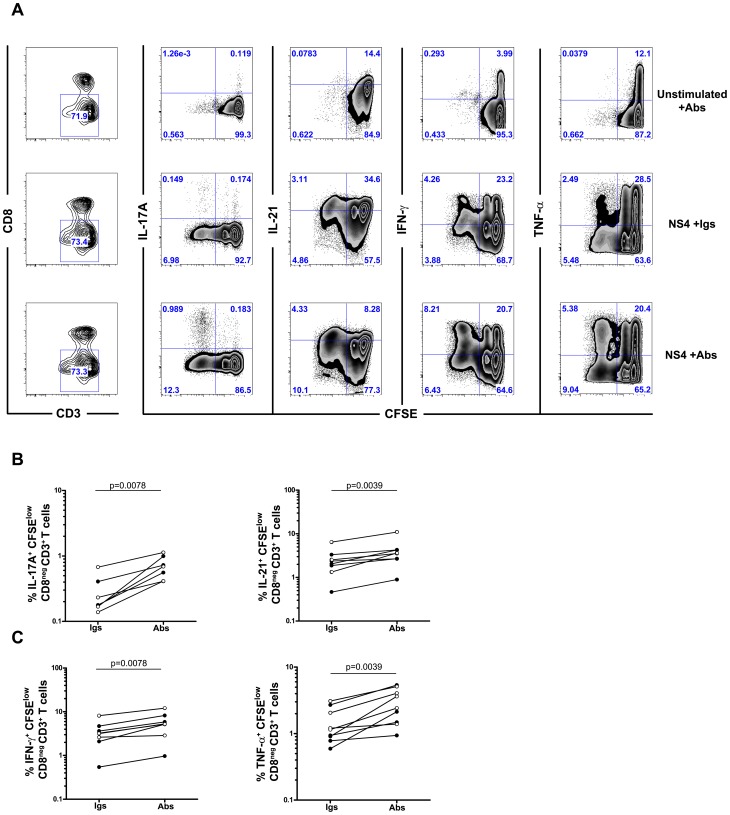
Restoration of HCV-specific IL-17A and IL-21 production by blocking multiple inhibitory pathways.(A) Representative FACS plot demonstrating enhanced production of Th17 and Th1 cytokines by HCV NS4-specific CD4 T cells upon antibody blockade. CD25neg PBMCs from acute HCV patients were stained with CFSE and stimulated with 1 µg/ml of HCV NS4 recombinant protein in the presence of control Igs (IgG1, Ig2a) or blocking antibodies against PD-L1, CTLA-4 and Tim-3 (10 µg/ml each). After 6 days of culture, cells were washed and re-stimulated with PMA/ionomycin to detect production of Th17 (IL17A, IL-21) and Th1 (IFN-γ and TNF-α) cytokines by ICS as described in Materials and Methods. Cells are gated on CD3+CD8neg lymphocytes (left panels). (B, C) Enhanced cytokine expression upon antibody blockade in the SR (open symbols, n = 3–5) and CI patients (closed symbols, n = 3–5). Data is represented as percent cytokine expressing CFSElow cells within the CD3+CD8neg lymphocyte gate. P-values were calculated using Wilcoxon signed rank test.